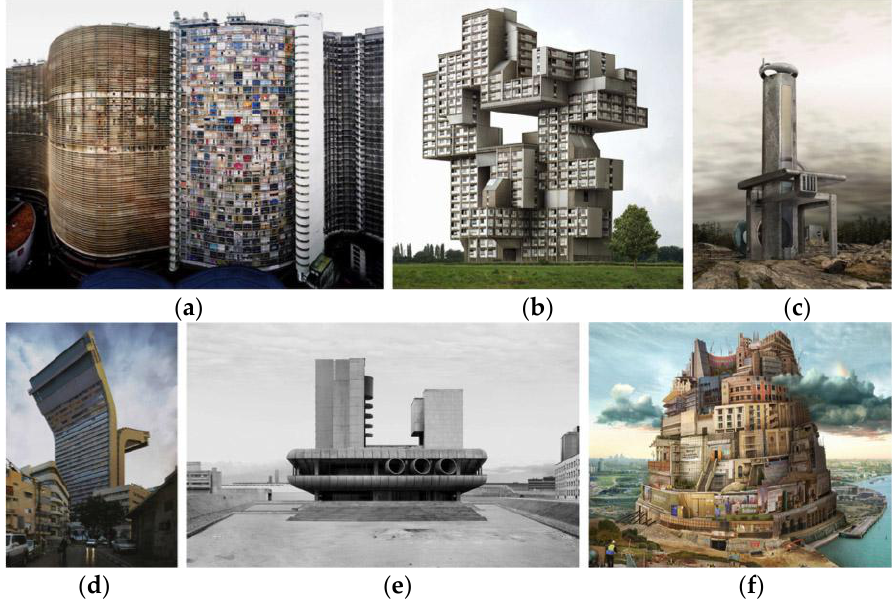
Figure 7. ( a ) Andreas Gursky, Copan , 2002; ( b ) Filip Dujardin, Untitled nr. 10 , 2012; ( c ) David Trautrimas, The Fragment Accumulator , 2010; ( d ) Victor Enrich, Shalom nr. 1 , 2009; ( e ) Beate Gütschow, S nr. 14 , 2005; ( f ) Emily Allchurch, London Babel (after Bruegel) ,